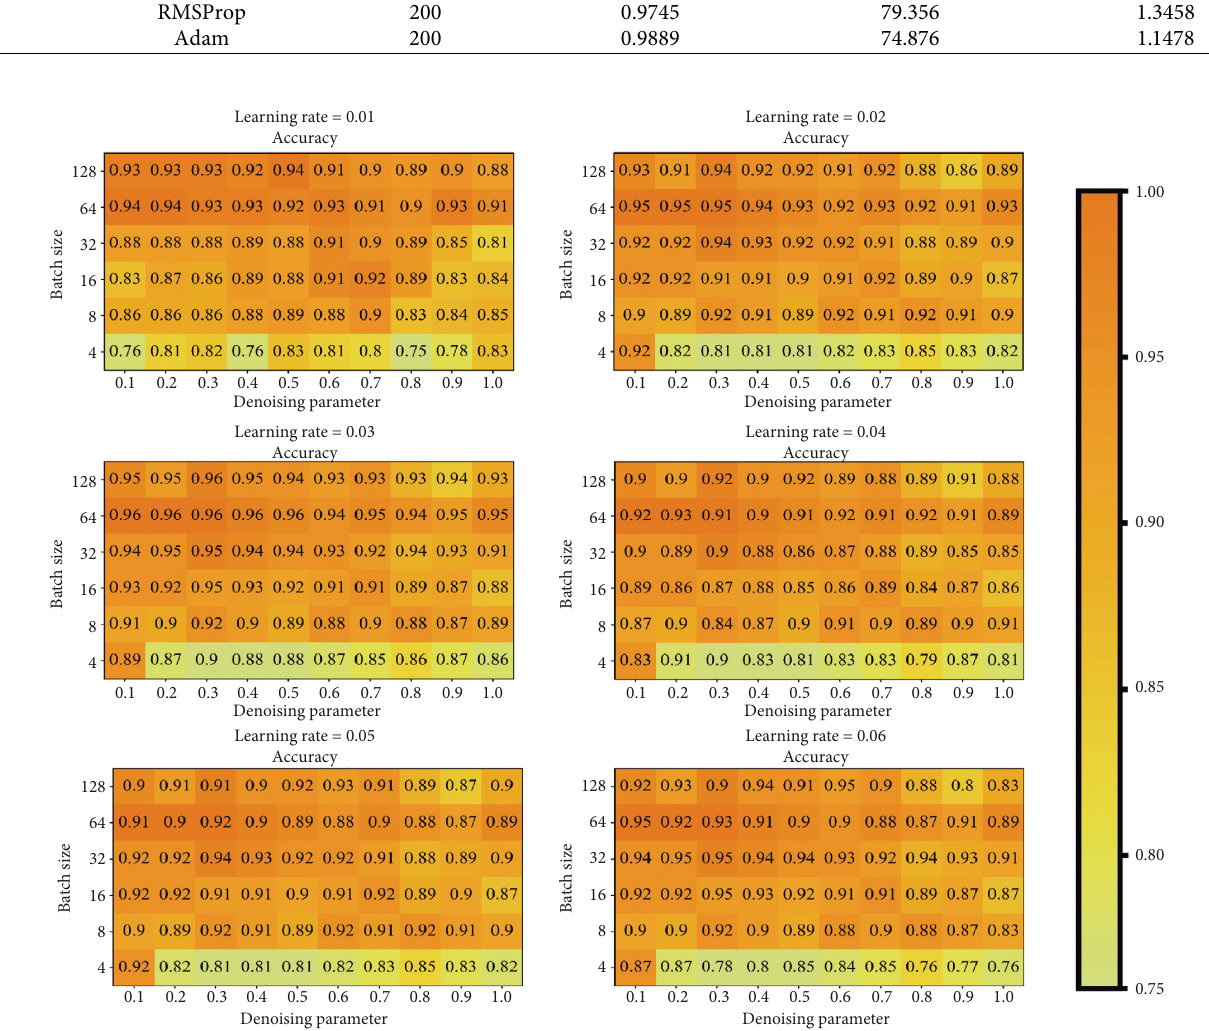
Figure 8: Results of different learning rates, batch size, and denoising parameters of grid search method. Table 5: Model training process final parameter.